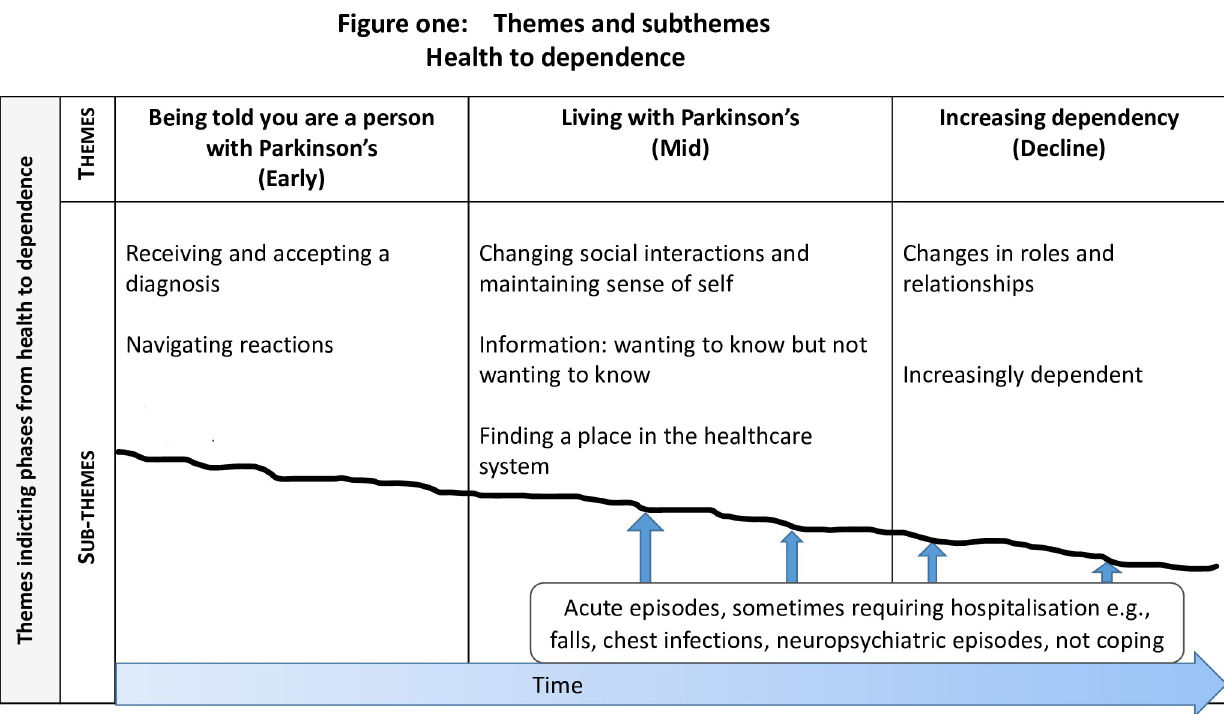
Fig 1. Themes and subthemes. The thick blue arrow reflects the movement though three phases as people transition through their Parkinson’s. The smaller vertical arrows represent multiple acute episodes which fall along this trajectory and will impact someone’s transitions. The faint line represents the undulating nature of